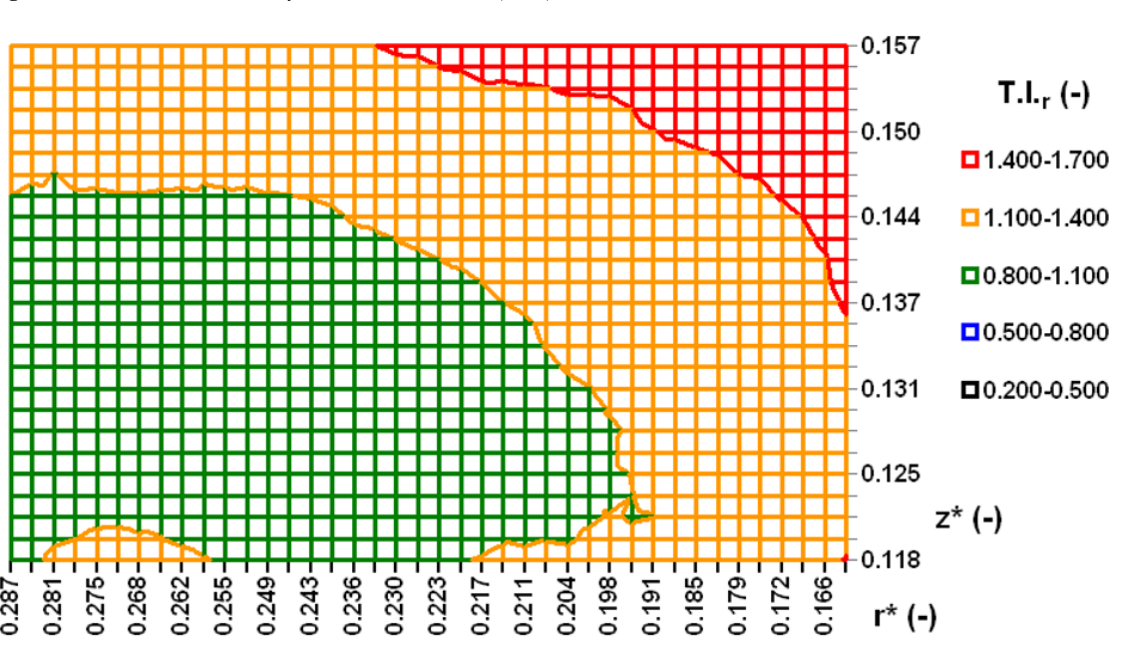
Fig. 12. Axial turbulence intensity distribution T.I. ax = f ( r * , z * ).